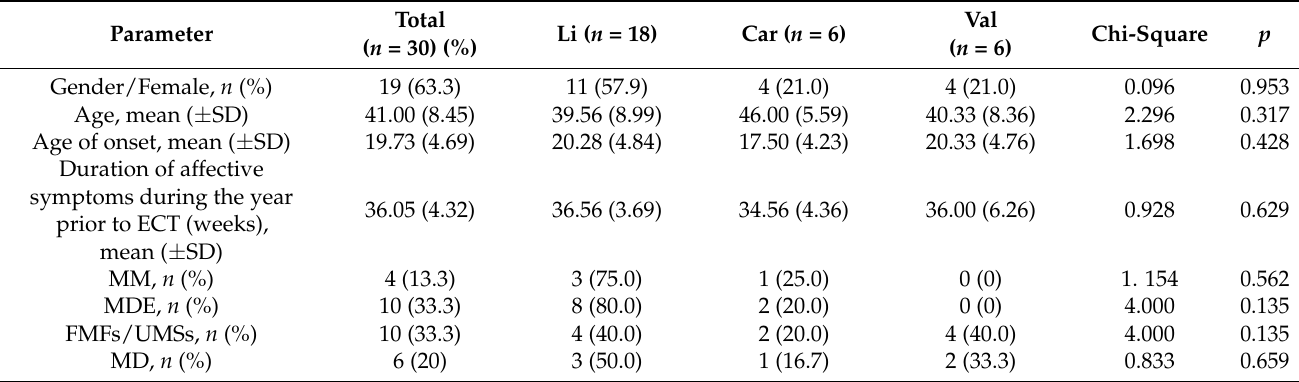
Table 1. Demographic and clinical characteristics of the medication groups (lithium, carbamazepine, and valproate).